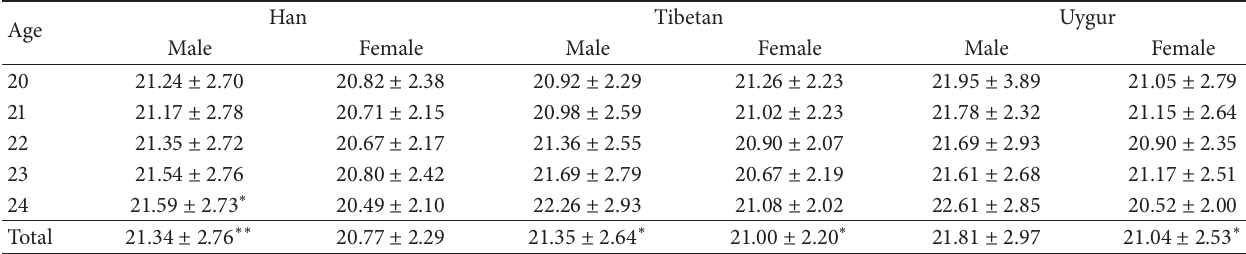
Table 5: Comparison among BMI, gender and age in Tibetan, Uygur and Han university students ( 𝑥 ± 𝑆 ) Kg/m 2 . Han Tibetan Uygur Age Male Female Male Female Male